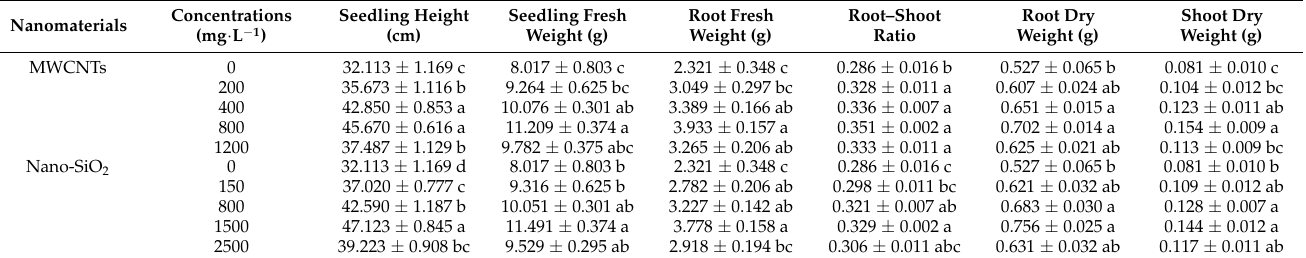
Table 1. Effect of different concentrations of MWCNTs and nano-SiO 2 on dry and fresh weight in maize.